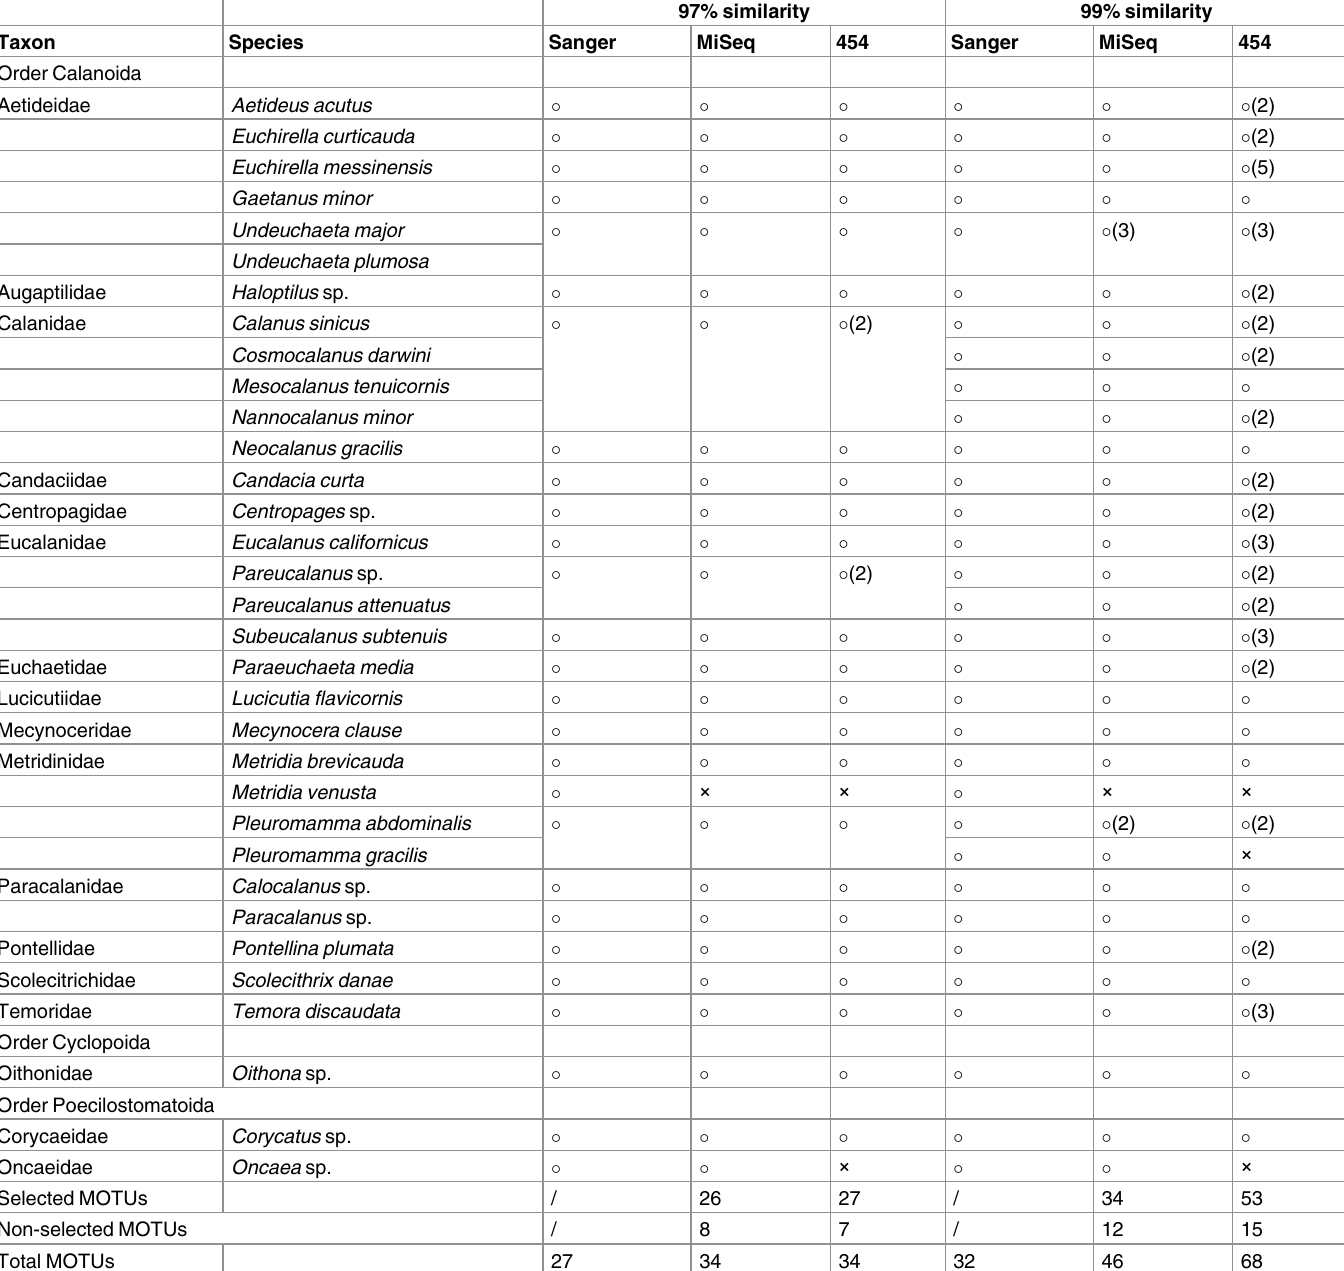
Table 2. Lists of species and MOTUs in the mock community analysis.